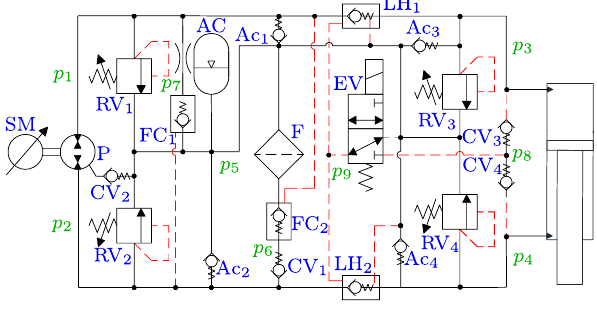
Figure 11: Self-contained cylinder architecture.